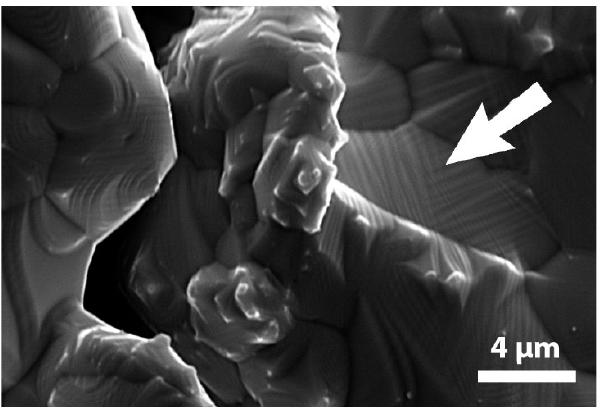
Figure 3. High magnification SEM micrograph of sample B, registered at room temperature. The arrow indicates martensitic twins .